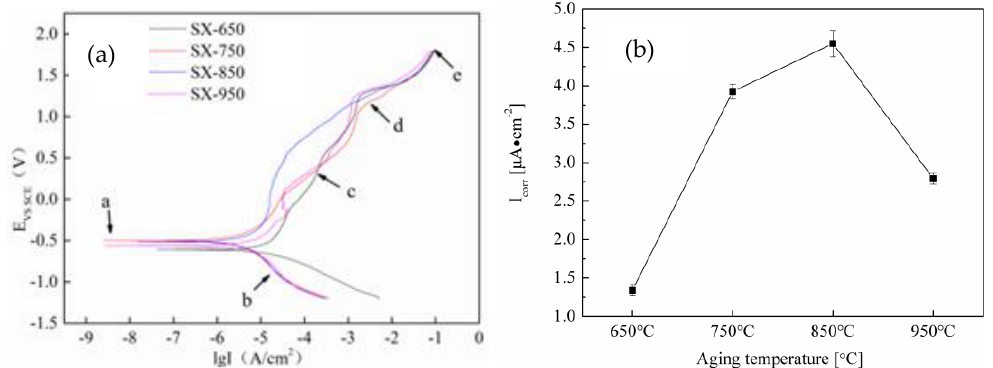
Figure 8. The polarization curves and corrosion current density of NSSC 2120 after aging at different temperatures: ( a ) Polarization curves; ( b ) corrosion current density.